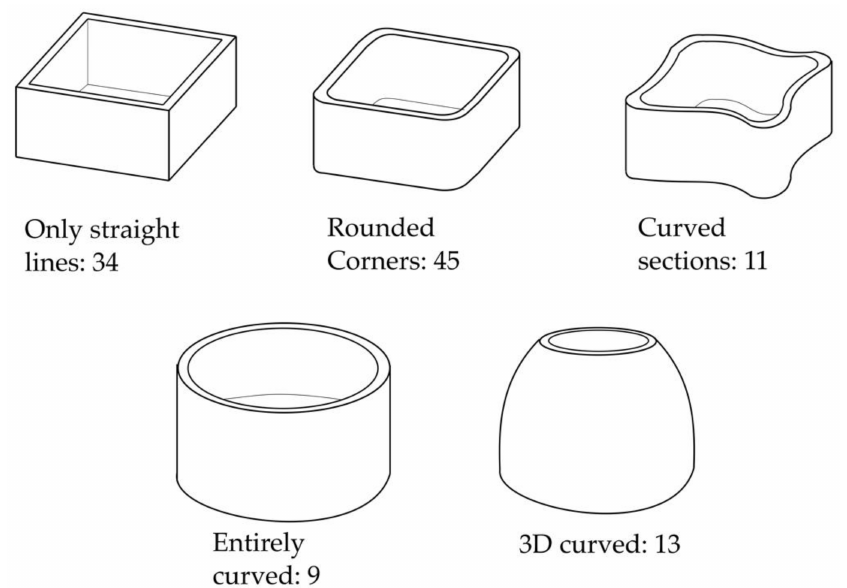
Figure 10. Types of architectural shape of 3D-printed constructions.